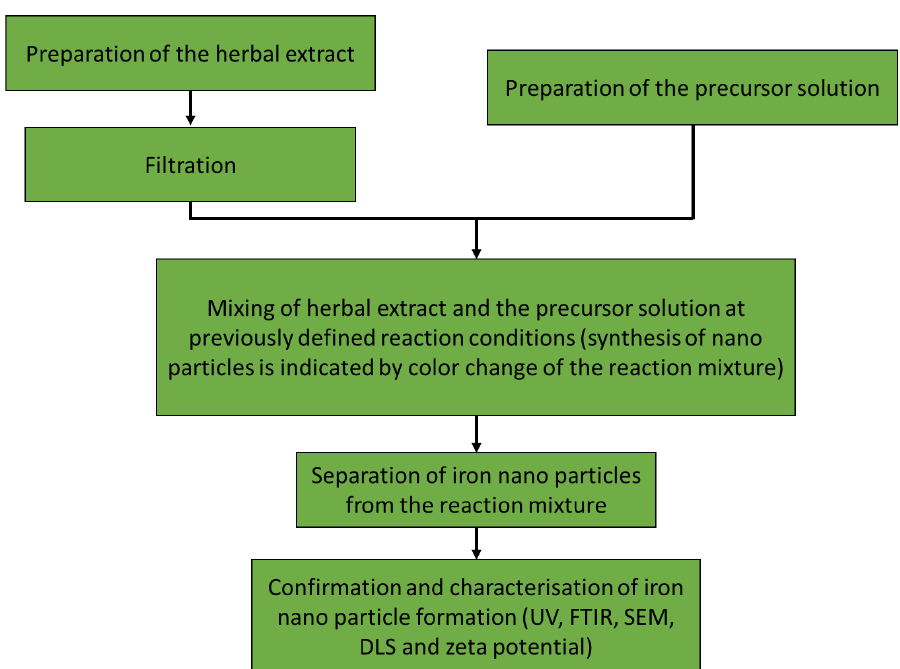
Figure 2. Flow diagram of batch synthesis of iron nanoparticles using herbal extracts.